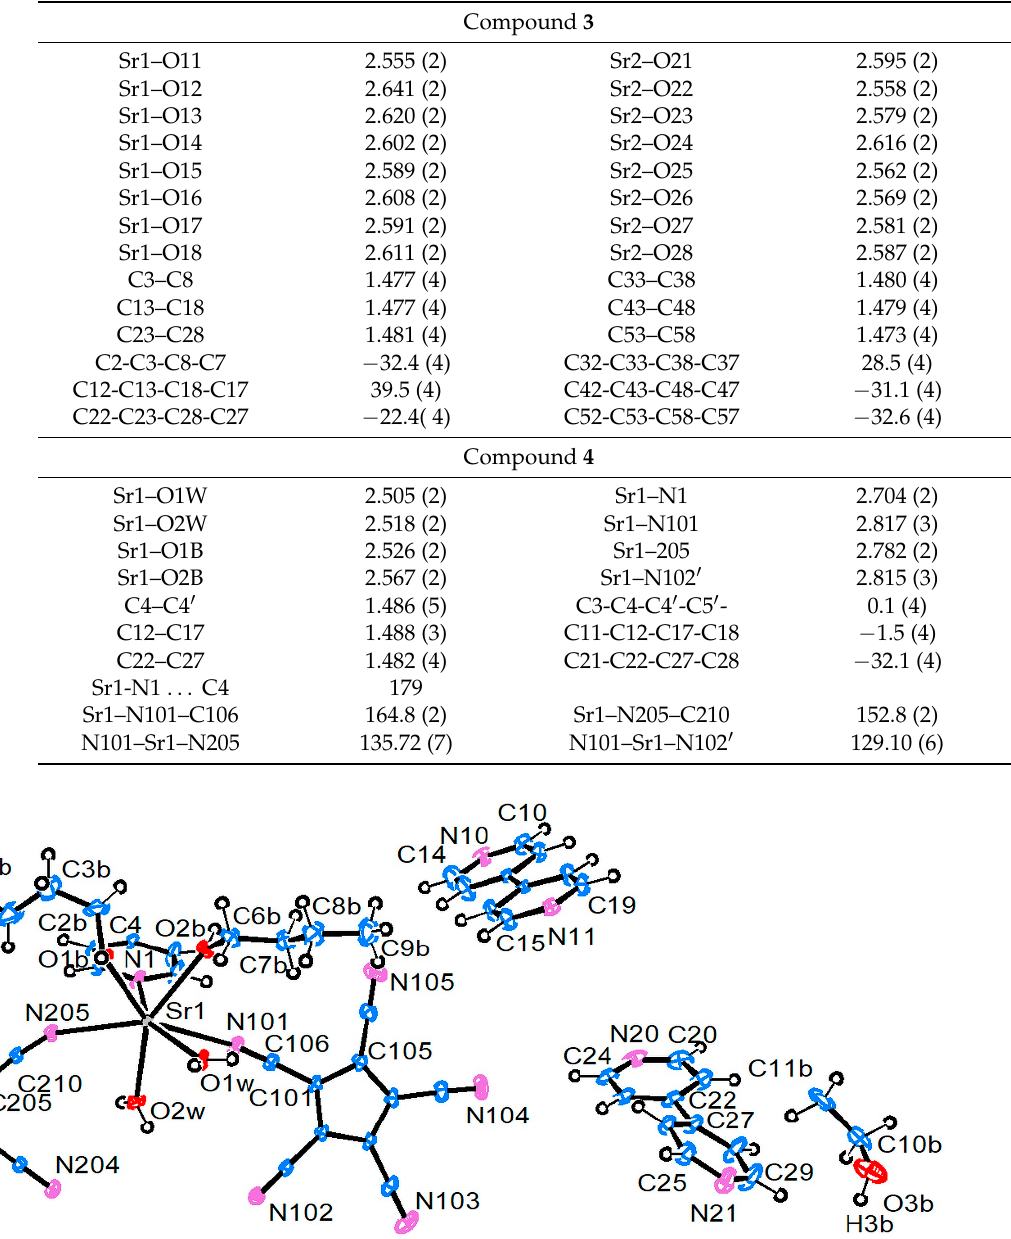
Figure 14. The asymmetric unit of compound 4 . Thermal ellipsoids at the 30% probability level. The Sr 2+ ion is eight-coordinated, by two water and butanol oxygens each, by three nitrile nitrogens and one Bipy nitrogen (Figure 15). Important bond parameters are collected in Table 2.